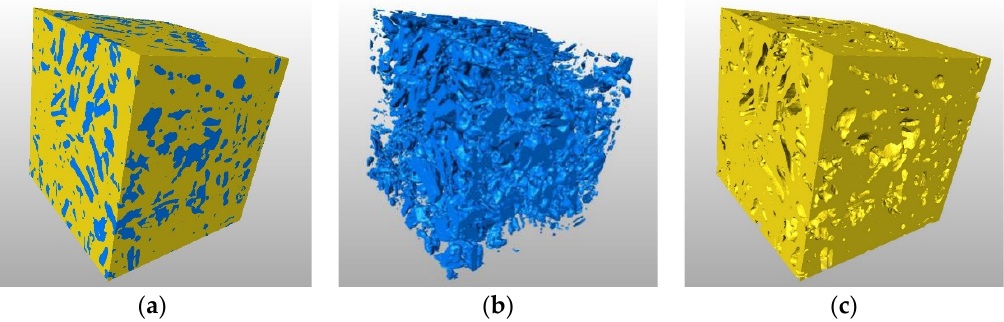
Figure 9. The 3D reconstructed model of REV2 of sample A and the extraction of pore network and solid. ( a ) Total. ( b ) Pore network. ( c ) Solid. Table 3. Porosity of